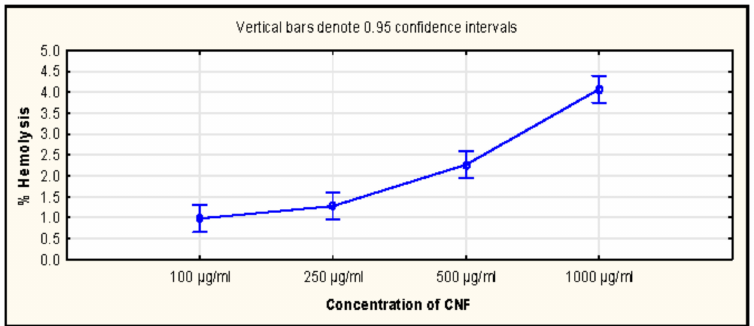
Figure 7. Hemolysis caused by di ff erent doses of wood-based cellulose nanofibrils (CNF) suspension.